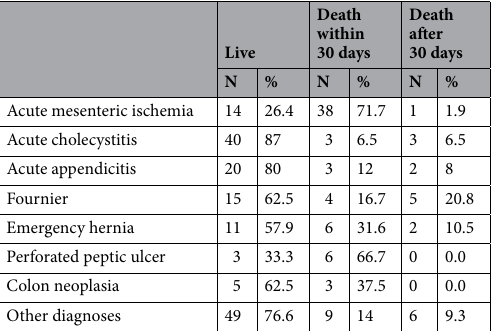
Table 2. Distribution of mortality by diagnosis.